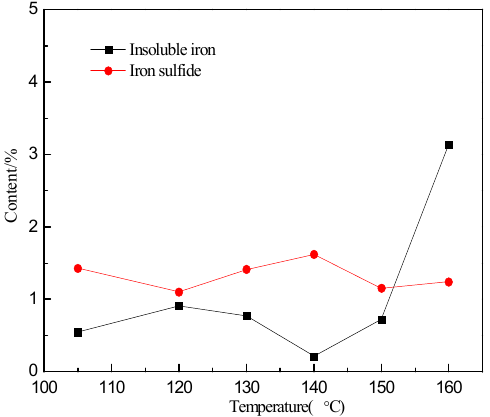
Figure 5. The content of different iron phase in the leach residue at different temperatures.